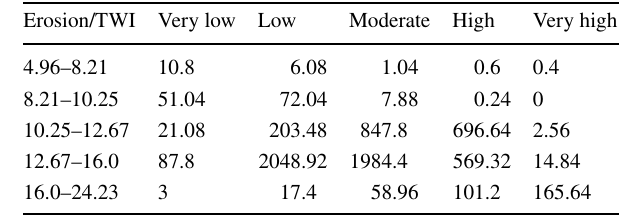
Table 10 Relationship between erosion and soil type Erosion/ Very low Soil type